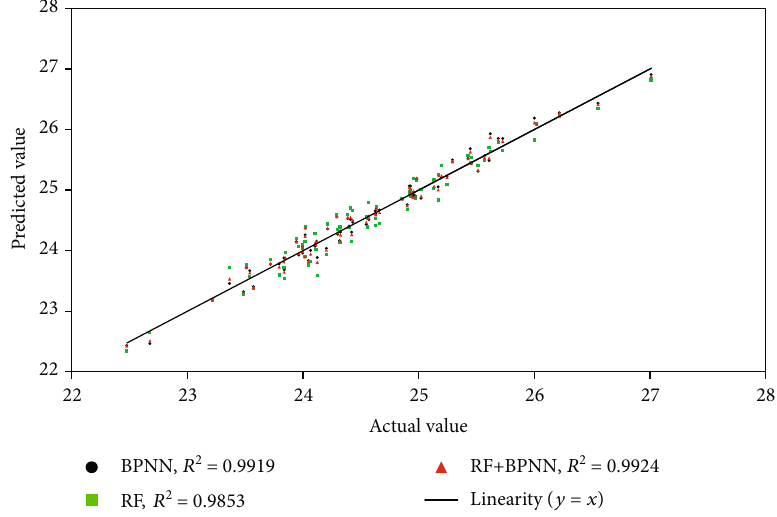
Figure 8: Comparison of the true and predicted values of CL. Table 5: Comparison of RF-BPNN with existing model